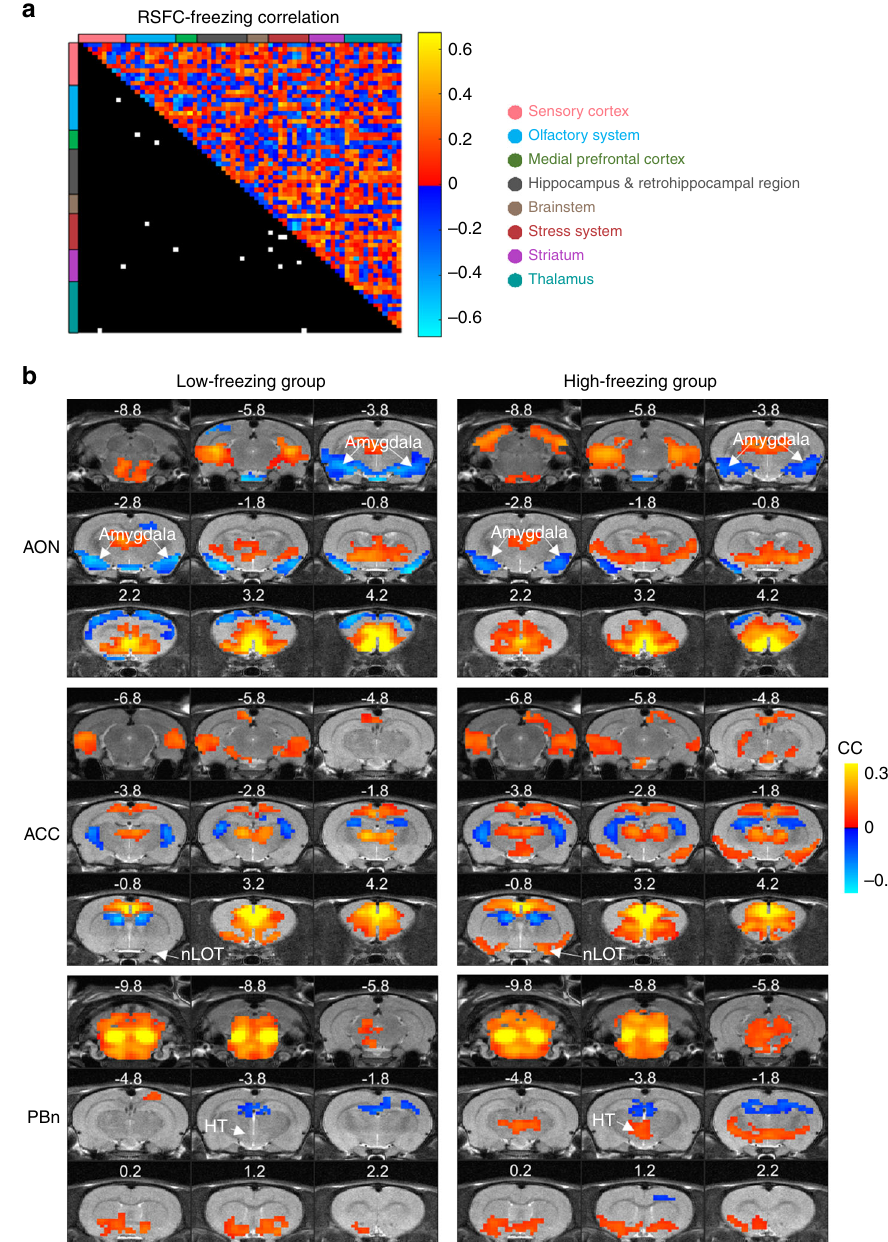
Fig. 4 Pre-trauma functional connectivity correlated to differential fear responses. a Correlations between pre-trauma RSFC and freezing time for all connections (upper triangle) and super-threshold connections (lower triangle, each white element represents a supra-threshold connection). Brain regions are arranged based on the brain system (color coded) they belong to. b Three representative RSFC maps, generated with ACC, AON, and PBn as the seed, respectively (colored voxels, p < 0.05, FDR corrected). Distance to Bregma was labeled at the top of each slice. ACC, anterior cingulate cortex; AON, anterior olfactory nucleus; HT, hypothalamus; nLOT, lateral olfactory tract nucleus; PBn, parabrachial